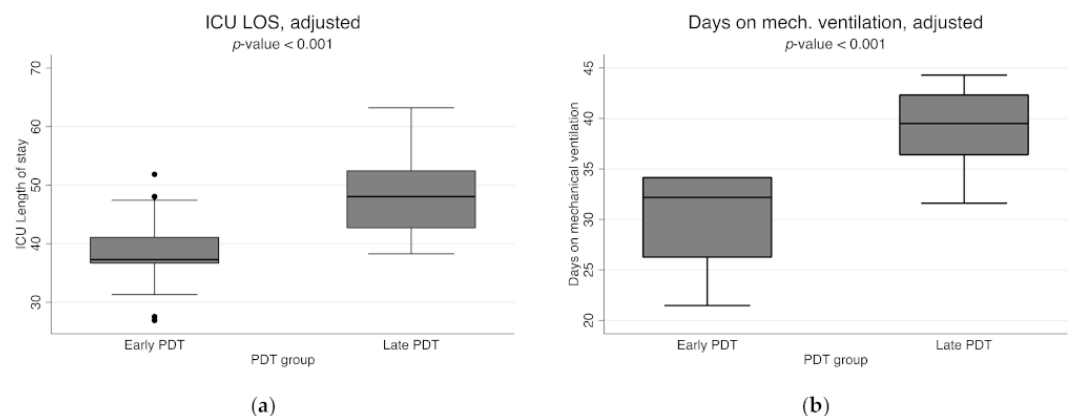
Figure 5. Boxplot of ICU length of stay ( a ) and days of mechanical ventilation ( b ) estimates, adjusted for confounding factors between the two groups (early group and late group). Legend: PDT, percutaneous dilatational tracheostomy; ICU LOS, Intensive Care Unit length of stay; early group, the group of patients who underwent PDT within the first 12 days of orotracheal intubation; late group, the group of patients who underwent PDT more than 12 days after orotracheal